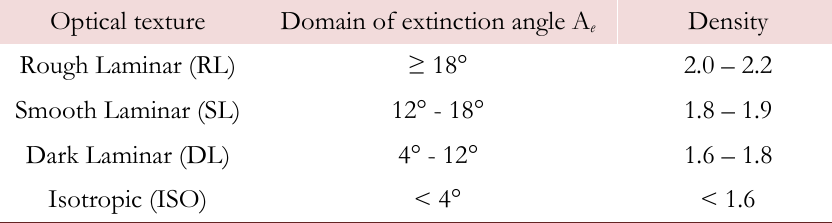
Table 2: classification of Py-C optical